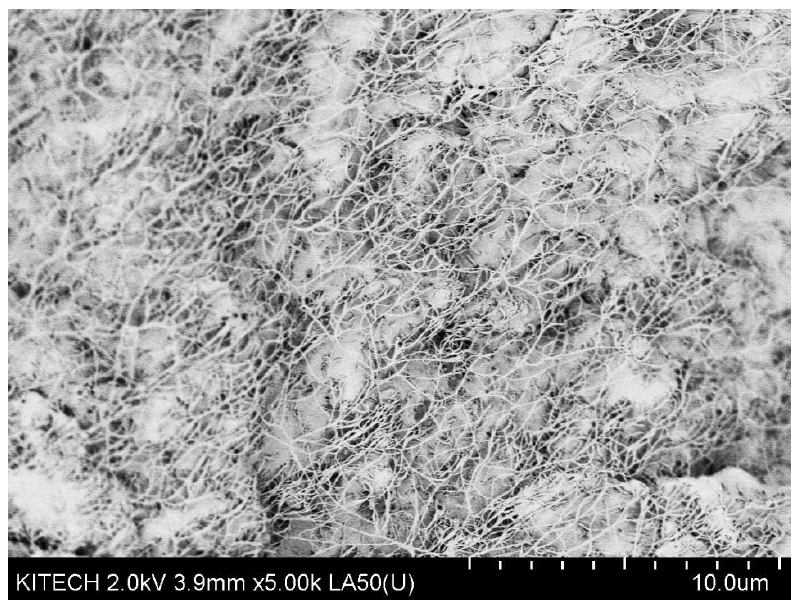
Figure A5. SEM image of the 4.29 wt.% SWNT/PP composite.